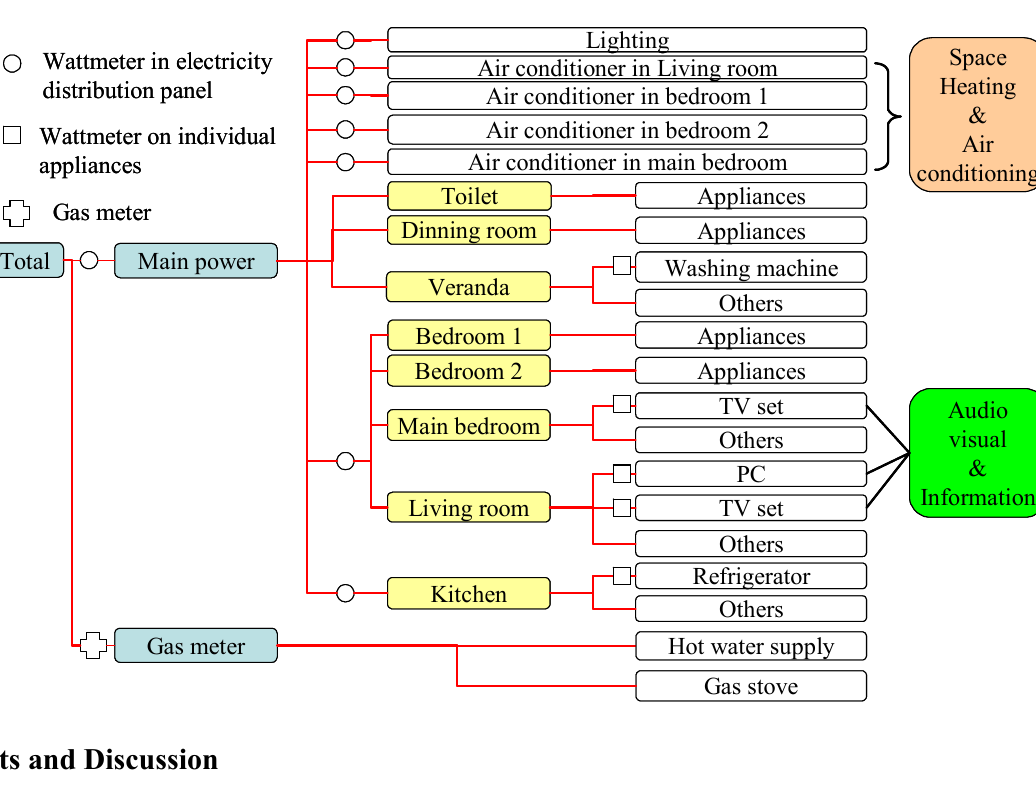
Figure 3. Location of measurement instruments and categories of energy use in House